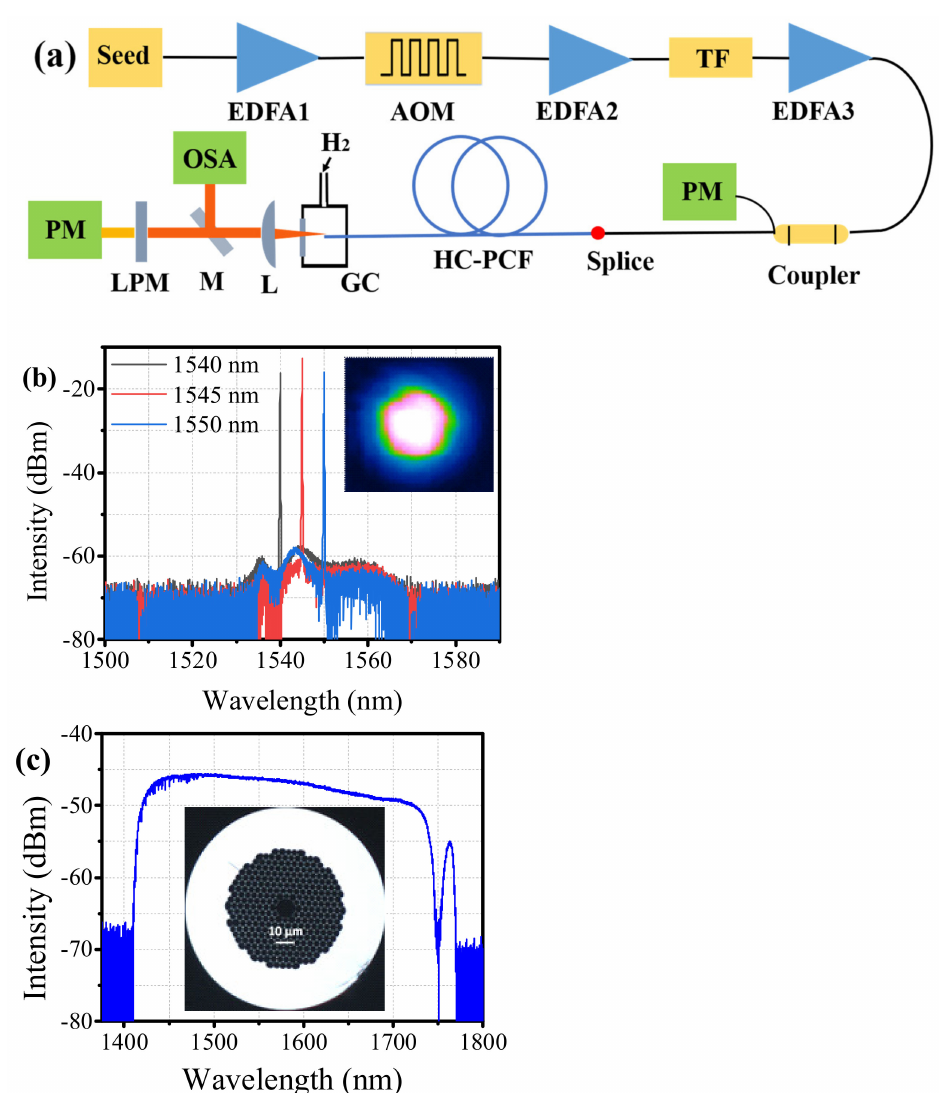
Figure 1. ( a ) Experimental setup: EDFA, erbium-doped fiber amplifier, AOM, acoustic optical modulator, TF, tunable fiber filter, GC, gas cell, L, convex-plane lens, M, silver mirror, LPF, long-pass filter, PM, power meter, OSA, optical spectrum analyzer; ( b ) The spectra of pump source at different wavelengths at the maximum output power. Insert: the near-field pattern of the pump beams; ( c ) The measured transmission spectrum of the 9-meter-long HC-PCF. Insert: the measured optical microscope image of cross section of the